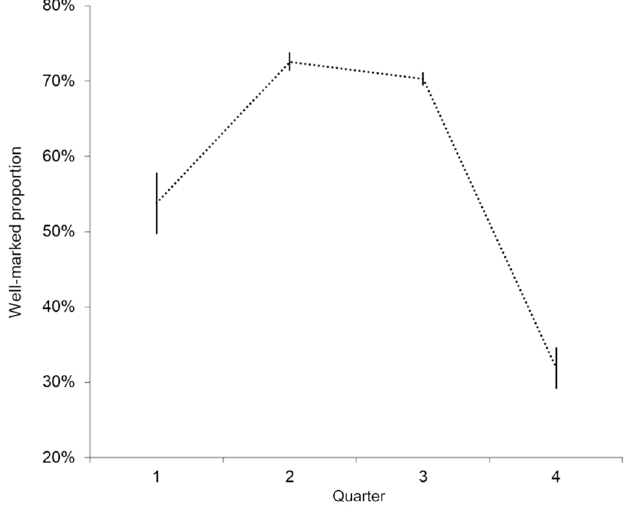
Fig. 3. Quarterly proportion of growth rings classi fi ed as “ well- marked ” in scales of Pagrus pagrus sampled in southern Brazil between 1976 and